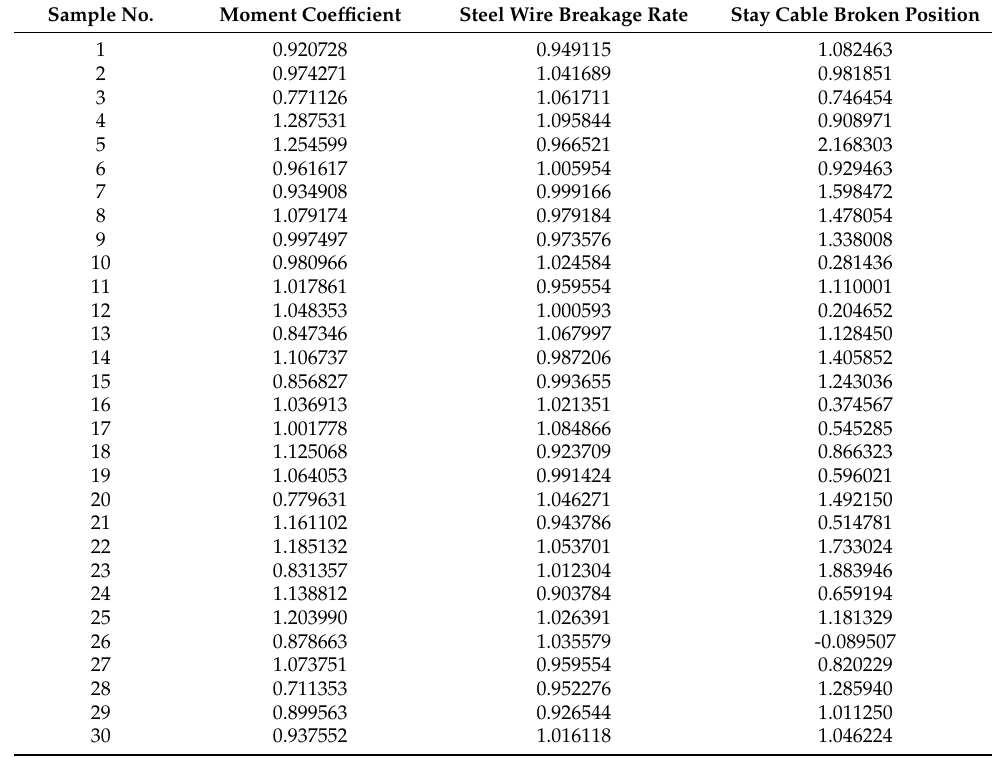
Table 5. Results of LHS for 30 times for different